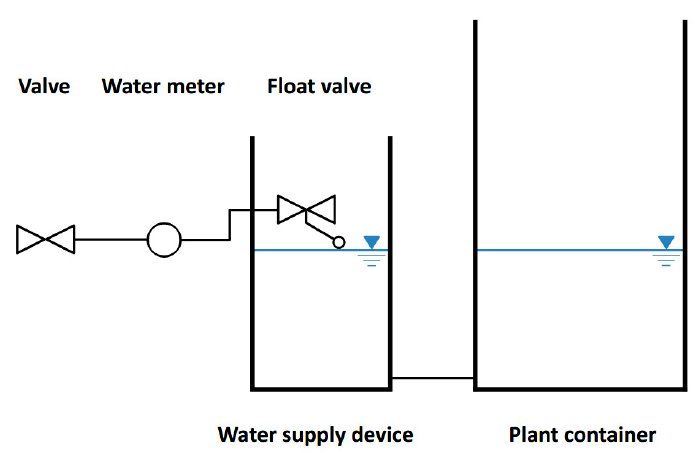
Figure 1. Schematic overview of the water supply device. Plant container and water supply device are connected by a hose pipe.